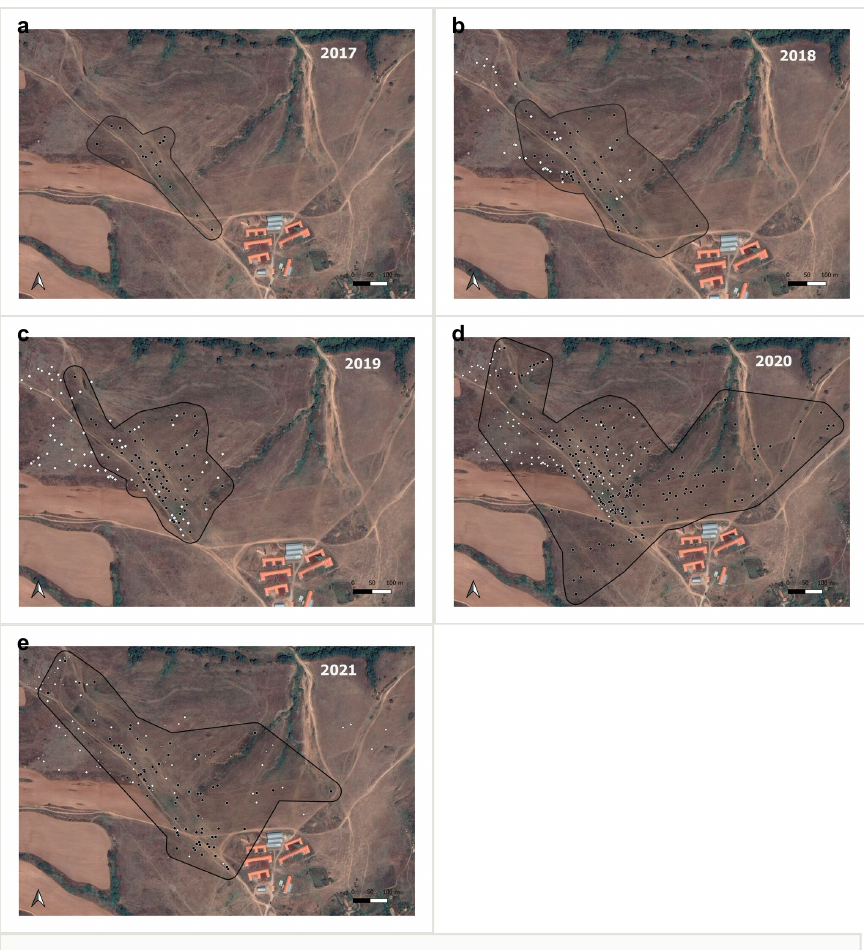
Figure 3. Distribution of European ground squirrel's burrows holes (black circles) and Harting's voles's colonies (active - white diamonds, abandoned - grey triangles) in Momina tsarkva during the study period. The colony of S. citellus is marked as a black-dotted polygon, based on the mapped burrow holes with 30-metres